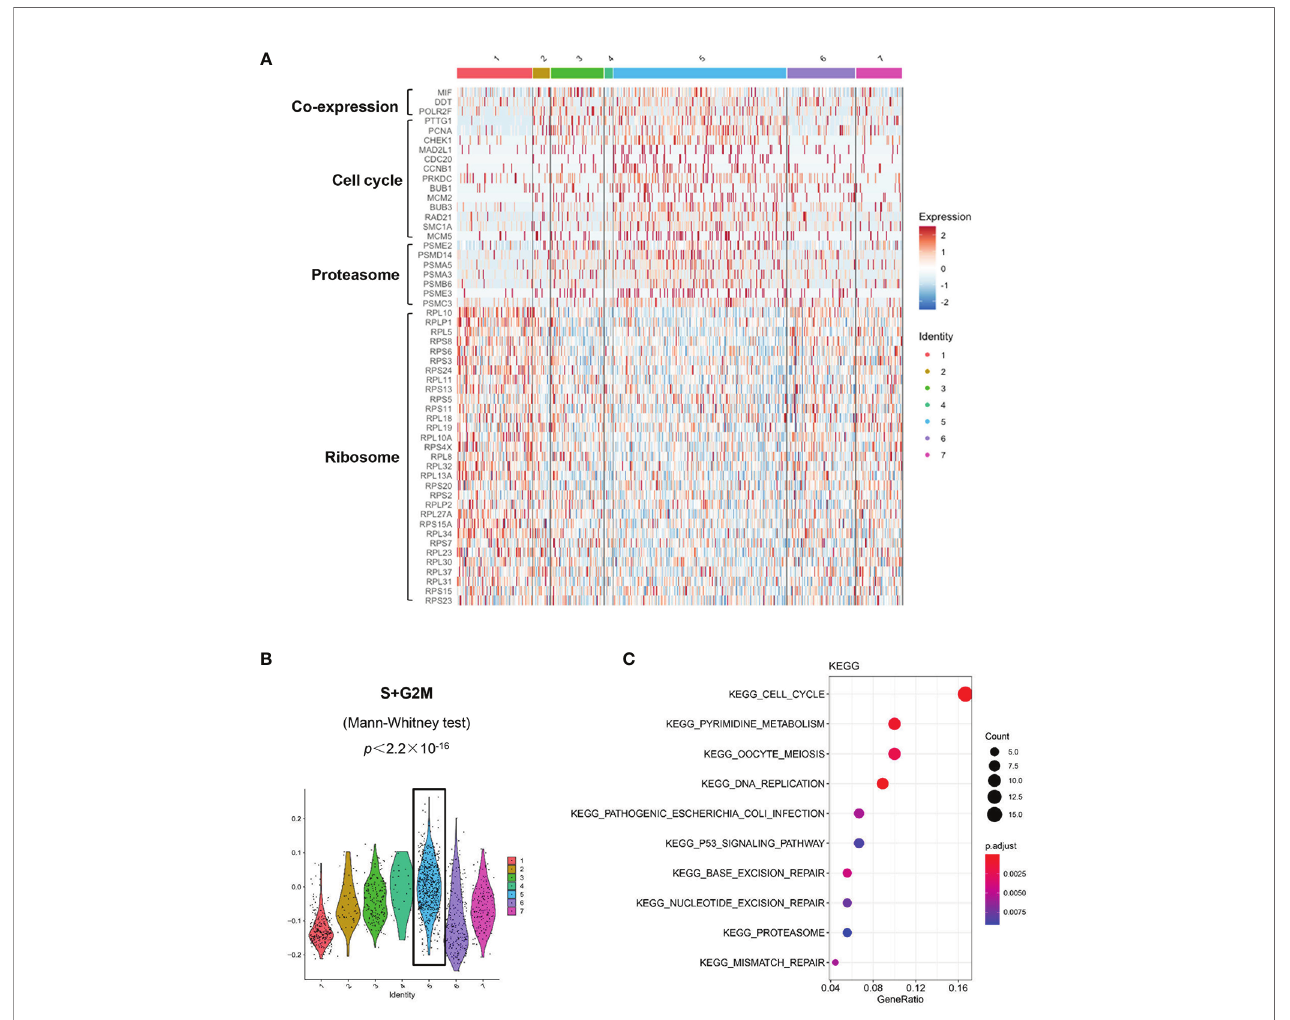
FIGURE 6 | Distinct transcriptomic pro fi les of MM cells with differential MIF expression. (A) A heatmap of marker genes reveals distinct transcriptomic pro fi les of the MIF High initial state (cluster #5) versus the MIF Low end state (referring to cluster #1; cluster #6, lack of obvious gene expression signature, might actually be transitional). (B) Active proliferation is found in cluster #5 with a signi fi cantly higher score of S and G2/M-phase. (C) KEGG enrichment analysis indicates some important pathways, such as cell cycle, proteasome and p53 signaling pathway in cluster